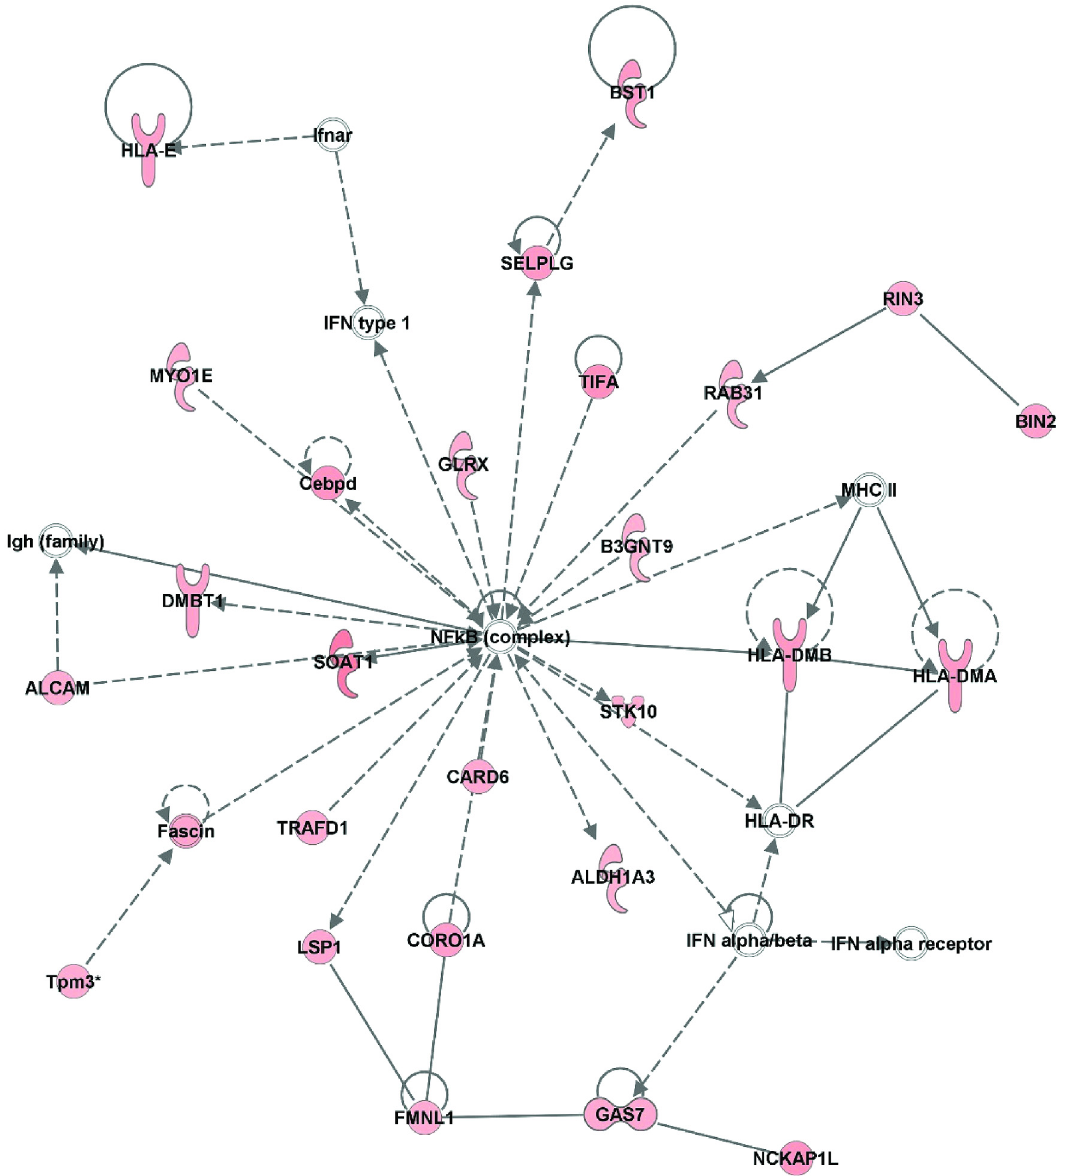
Fig 5. Second scoring network inclusive of up-regulated genes (score = 40) in LOCK vs RUN. Nodes represent genes/molecules. Shading is proportional to fold change size (red: upregulated). Direct and indirect relationships are denoted with solid and dashed lines, respectively. White nodes denote network members that were not altered in the network. Lines ending in an arrow or blunt end indicate known direction of molecular activation or inhibition, respectively. Different shapes of genes represent different gene